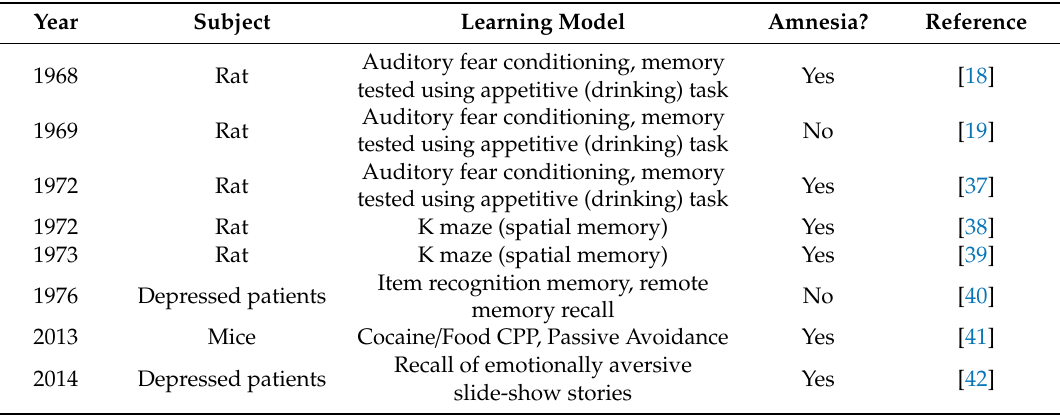
Table 1. Studies that have used electroconvulsive shock (ECS) to interfere with